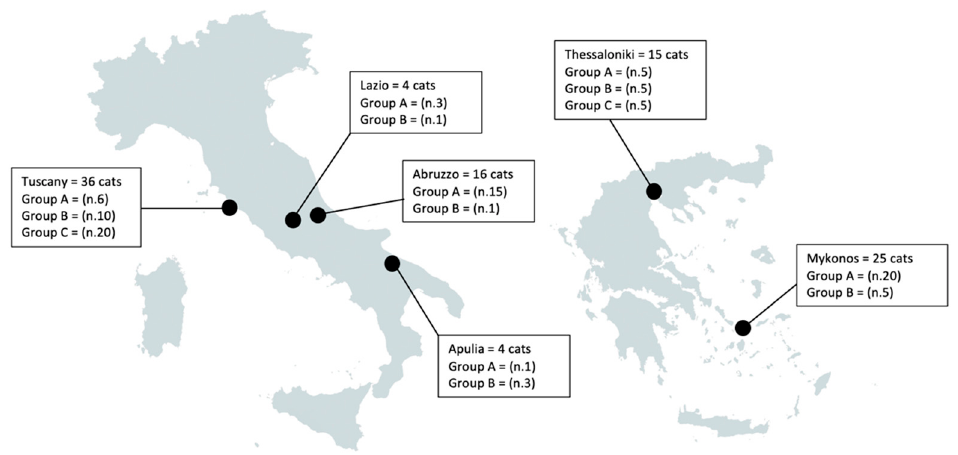
Figure 1. Study sites and number of cats enrolled in the study for each geographic area.